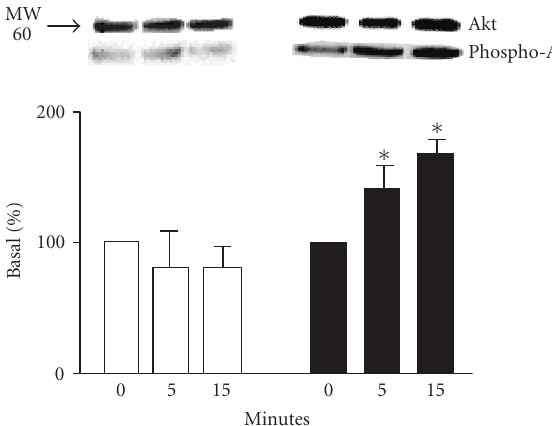
Figure 2: Akt activation following β -AR stimulation . HEK 293 cells were transfected with β 1 -AR or β 2 -AR. Forty-eight hours after the transfection, cells were stimulated with 1 μ M isoproterenol for the indicated times. Akt activation status was determined by immunoblot for the phosphorylated form of Akt compared to the total amount of Akt after stimulation of β 1 -AR ( (cid:2) ) or β 2 -AR ( (cid:3) ) expressing cells. Top panel is a representative immunoblot of the experiments ( n = 4-5). Data from these experiments is quantitated in the bottom panel as described in Section 2. ∗ P < . 05 versus 0 minute.